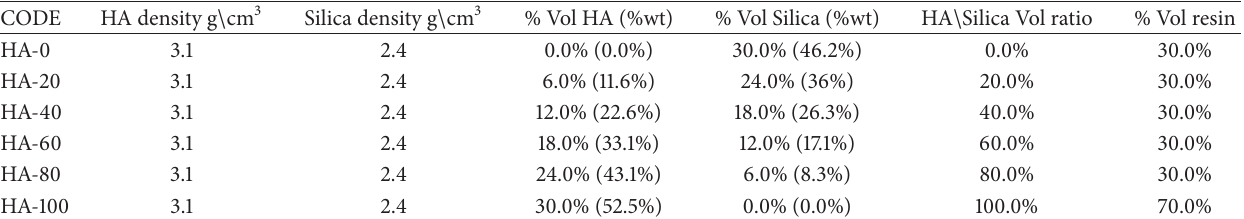
Table 1: Different volume fraction of HA whiskers and inorganic filler in resin based composite formulation.